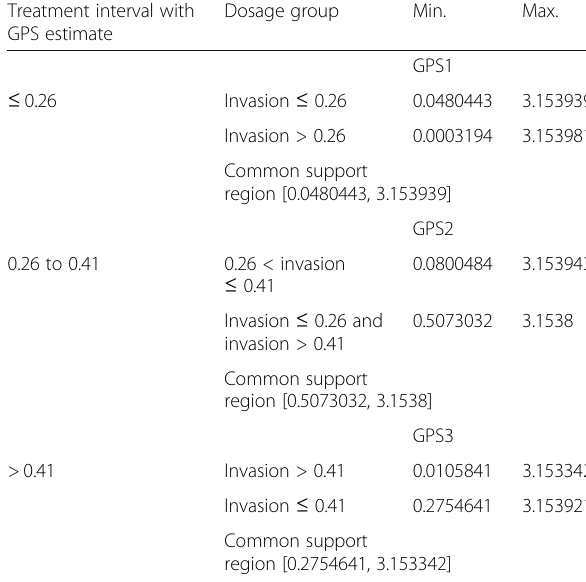
Table 8 Common support region Treatment interval with GPS estimate